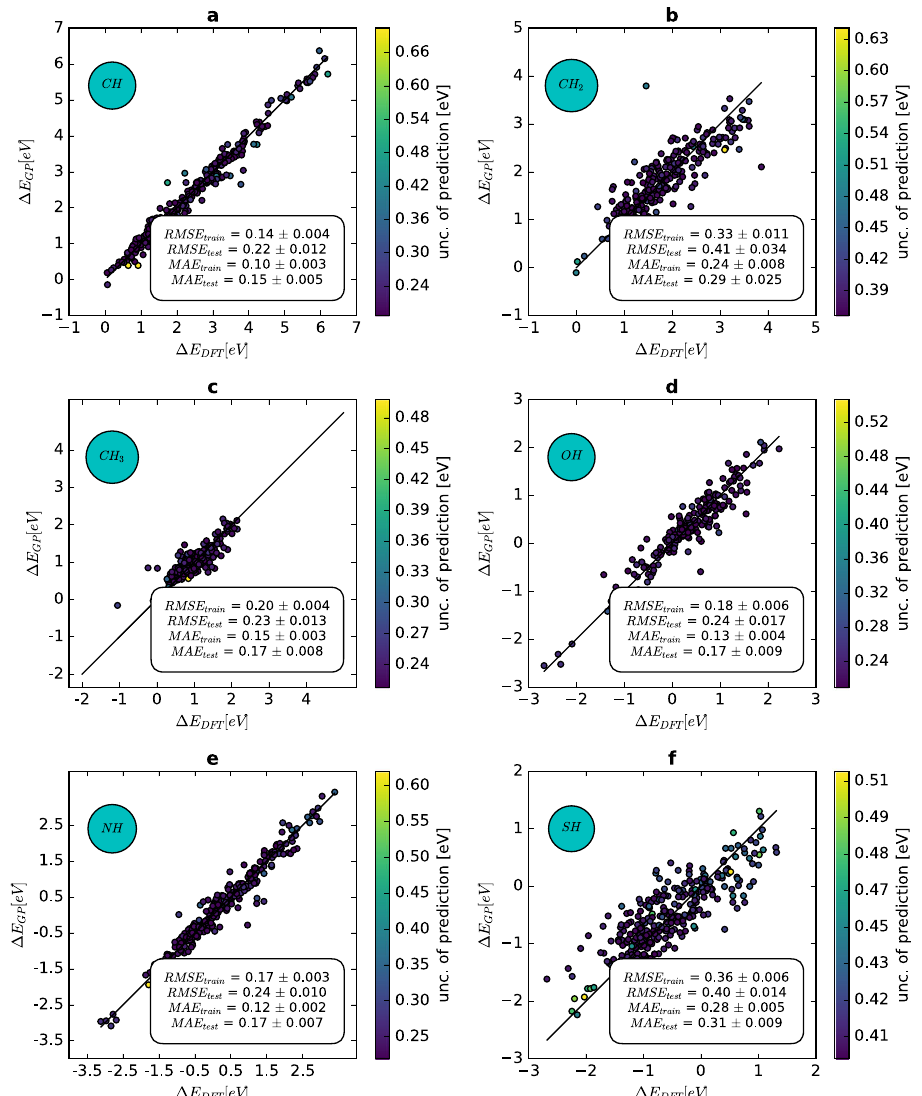
Fig. 5 Parity plot showing the Gaussian Process predicted Chemisorption energies of AH x plotted against the DFT-computed chemisorption energies for the testing set. a CH *, b CH 2 *, c CH 3 *, d OH *, e NH *, and f SH *. We show the uncertainty in the prediction using a color bar shown in the right bar of each